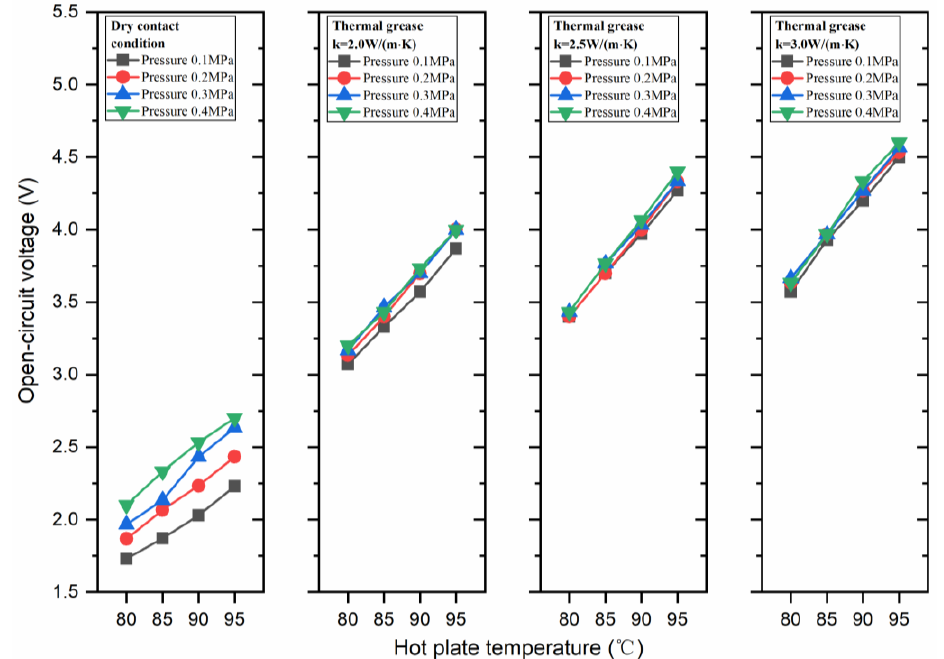
Figure 8. The open-circuit voltage varies with the external loads at different temperatures of hot plate and thermal interface materials.